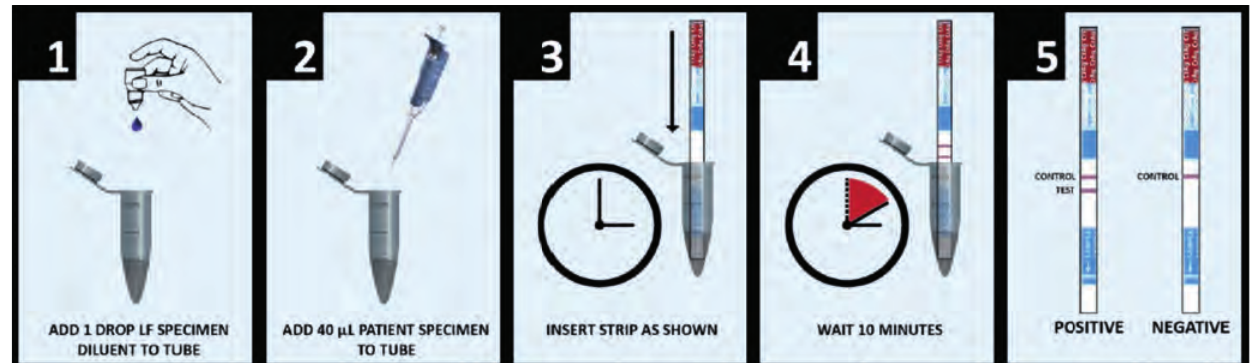
Fig. 2. Laboratory procedure to set up and read the cryptococcal antigen lateral fl ow assay (Immuno-Mycologics, Norman, OK) (source: Immy CrAg LFA package insert; reprinted with permission).